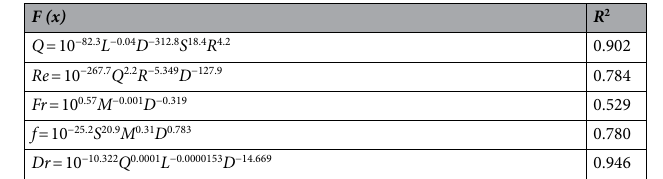
Table 5. Regression relationships between characteristic parameters of slope hydrodynamics and other variables. Q is the flow, Re is the Reynolds number of the water flow, Fr is the Froude constant, f is the resistance coefficient, D r is the rate of soil separation, L is litter length, D is litter average diameter, S is slope, R is rainfall intensity, M is litter coverage